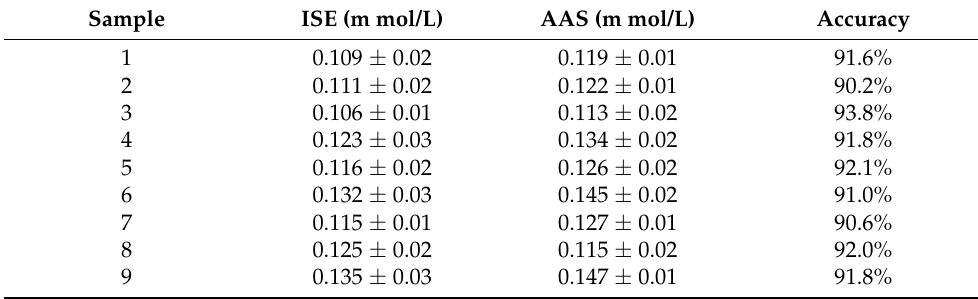
Table 2. Determination of K + in river water samples (mean ± standard deviation, n = 3). Sample ISE (m